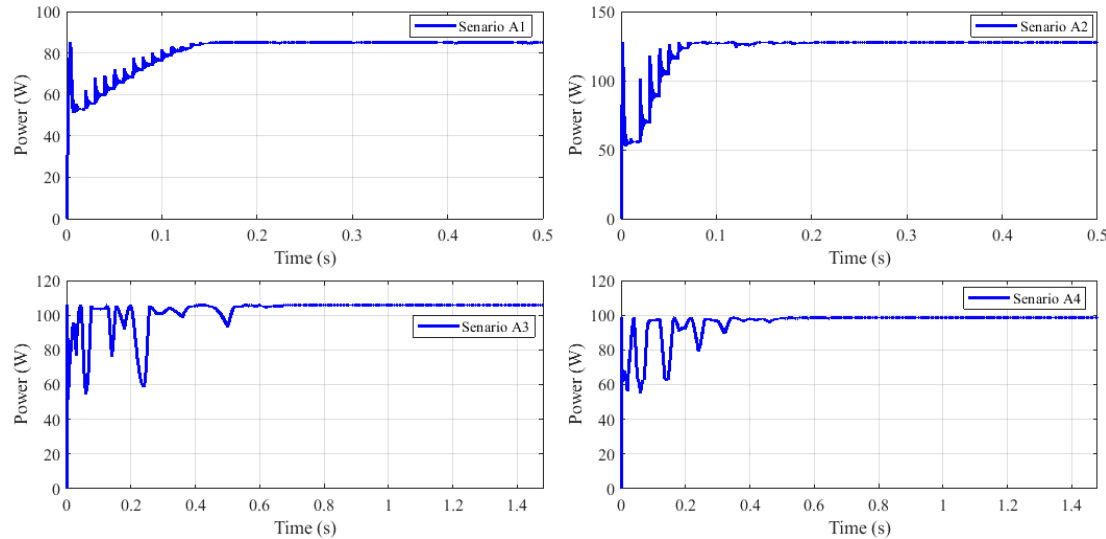
Figure A1. Power against voltage curves under different scenarios.